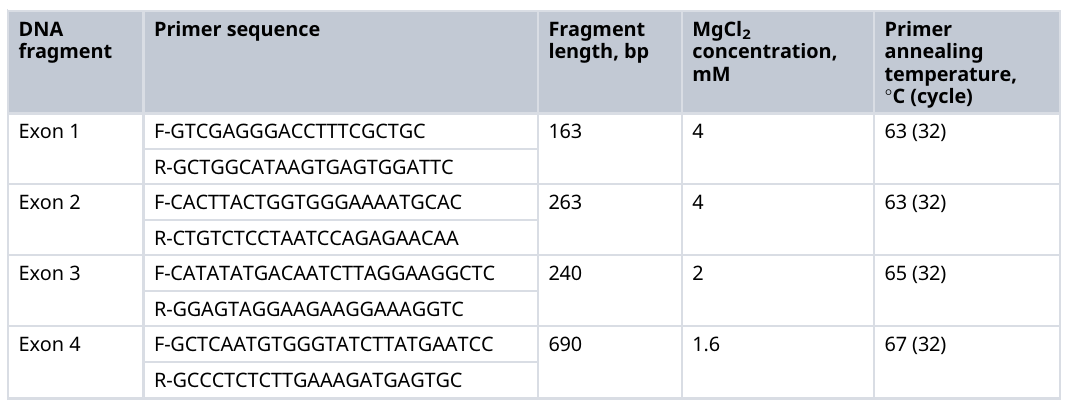
Table 1. Primer sequences and PCR conditions for FKBP14